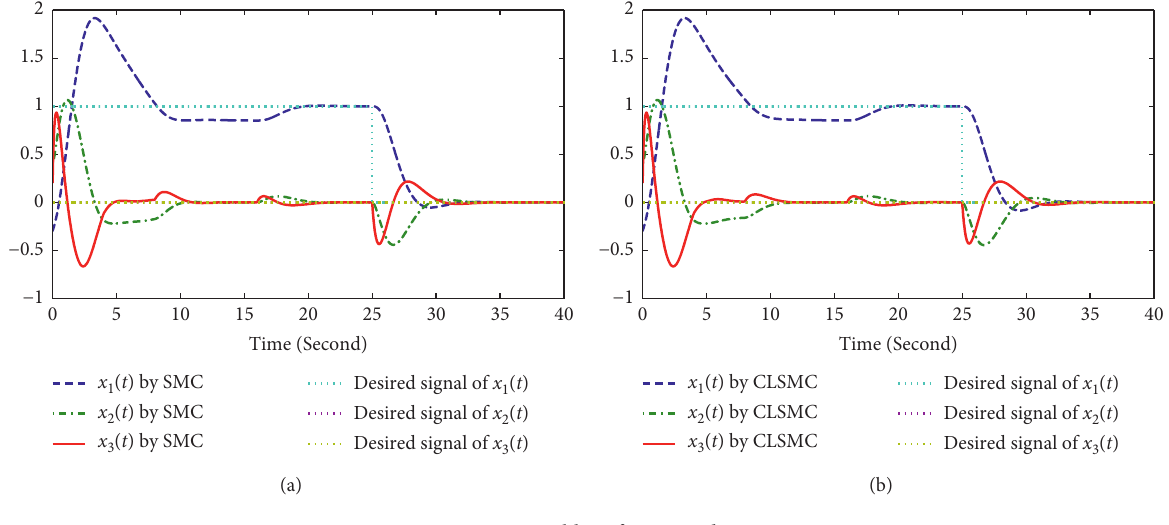
Figure 3: State variables of SMC and